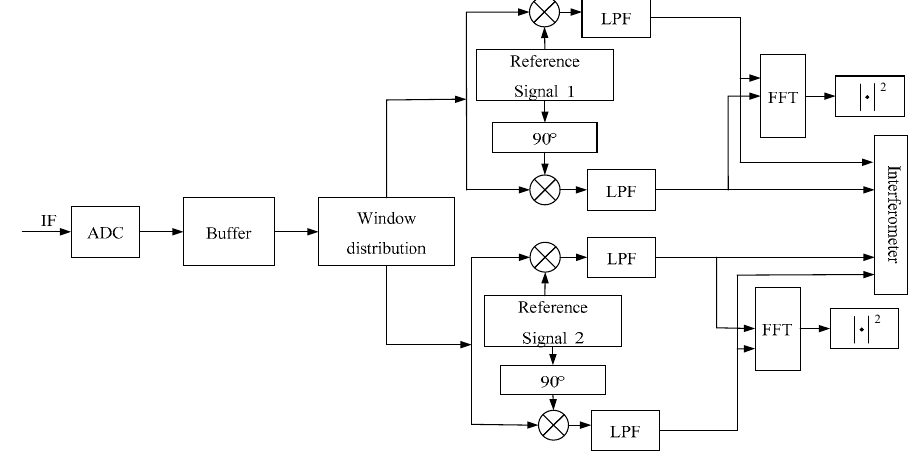
Figure 13. Diagram of signal processing.